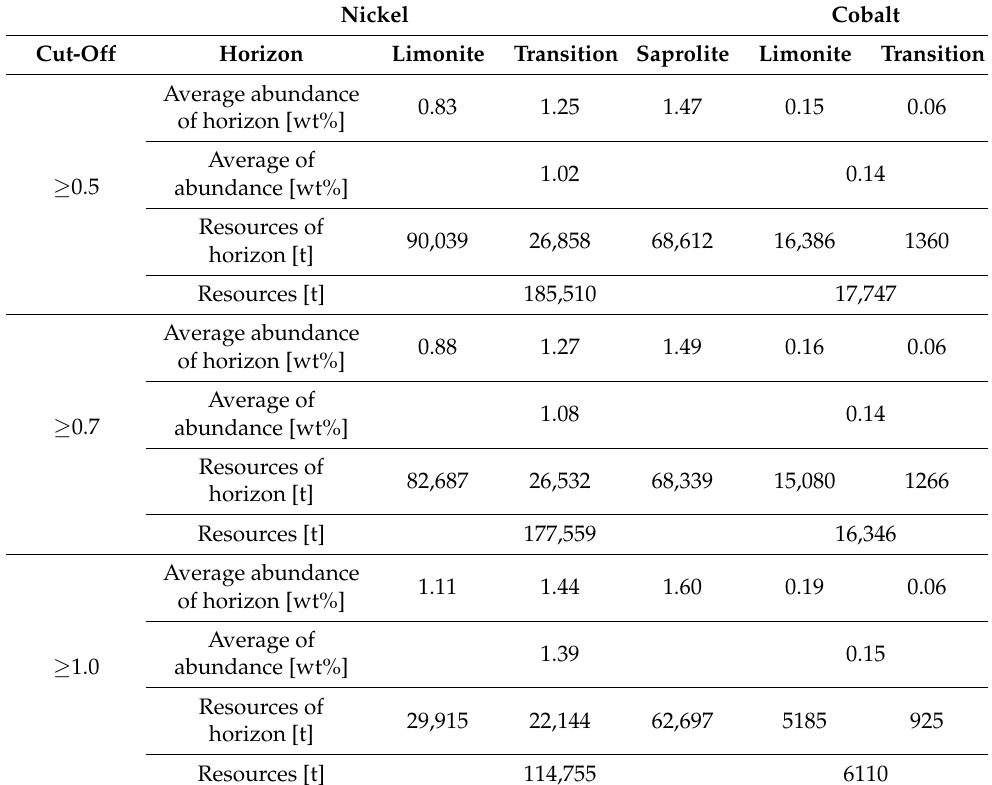
Table 8. Resource of useful elements estimated by the average abundance method for the whole identified area. Nickel Cobalt Cut-Off Horizon Limonite Transition Saprolite Limonite